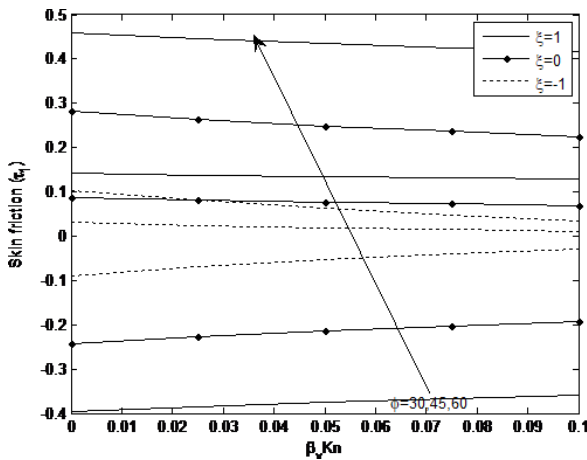
Fig. 9: Skin fraction ( τ 1 ) versus β v Kn for different of ϕ